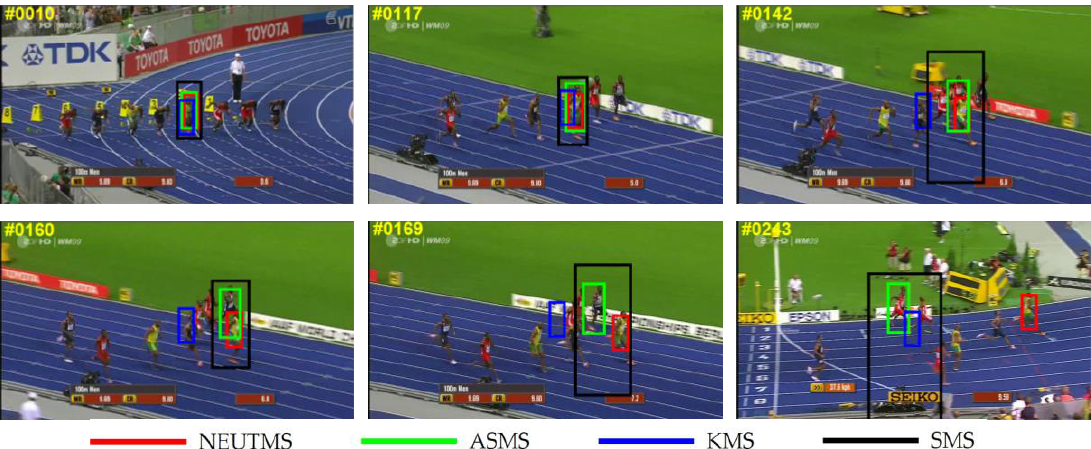
Figure 5. Screenshots of tracking results of the video sequence used for testing ( Bolt , target is selected in frame #1).